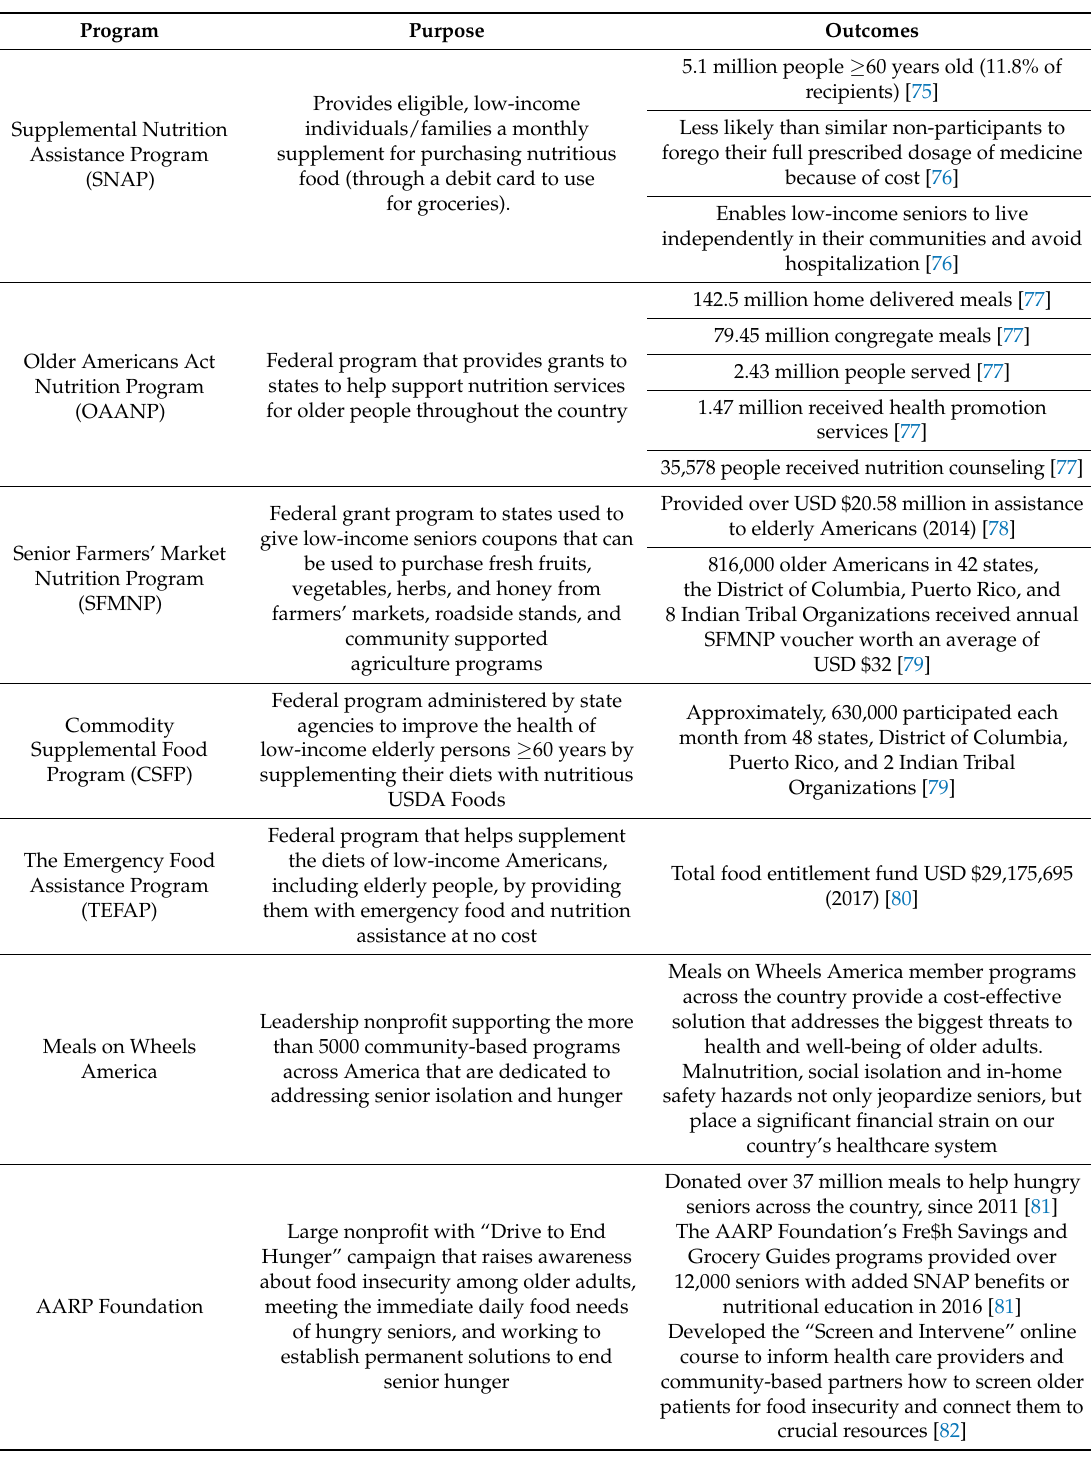
Table 3. U.S. food-related programs and associations for older